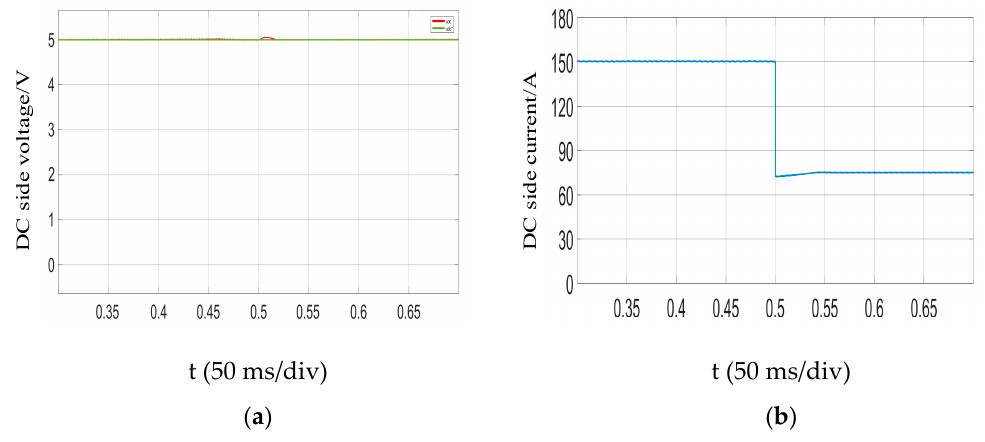
Figure 8. DC output voltage and current waveform when the load suddenly increases: ( a ) DC output voltage waveform; ( b ) DC output current waveform.